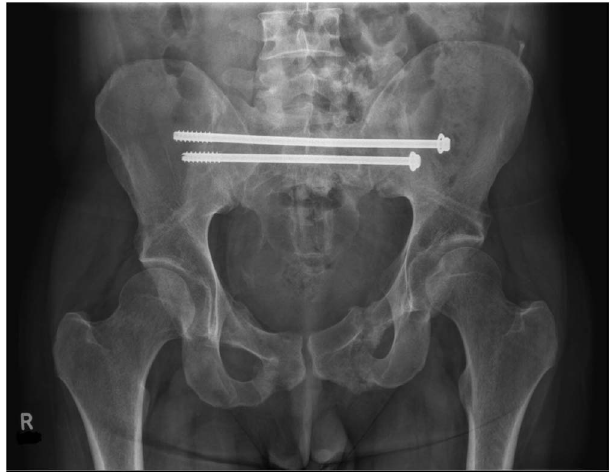
Figure 3. After removal of INFIX and anterior